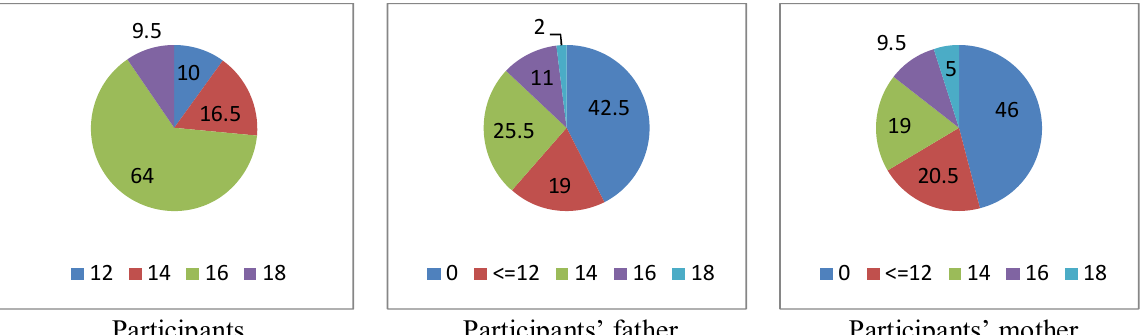
Fig. 2. Participants’ educational background in terms of years of